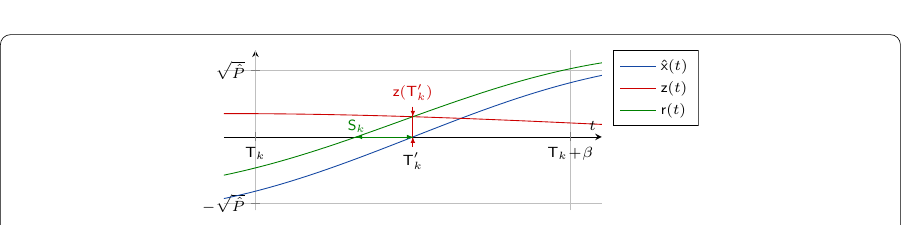
0 . 3 − Fig. 4 Numerically obtained distribution of ˜ x ( t k ) for a t k = t k ,TI and b t k = t k ,HP (solid lines) and bounds on the distribution (dashed and dashdotted lines) for different κ . For lower-bounding the mutual information rate, a Gaussian distribution with the obtained upper bound on the variance of ˜ x ( t k ) is suitable for κ ≲ 3